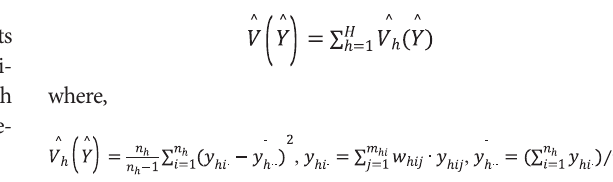
Table 2. KNHDIS databases between 2004 and 2008